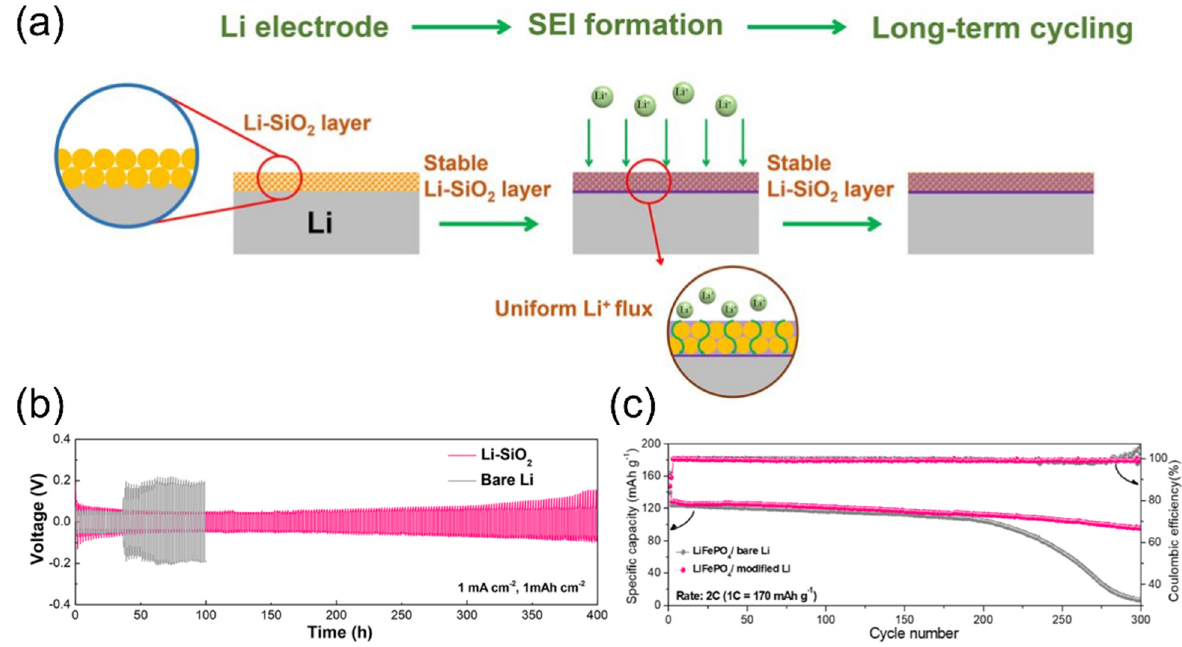
Figure 11. ( a ) Schematic drawing illustrating the fabrication of a conformal Li 4 SiO 4 -based hybrid layer for the dendrite-proof metallic lithium anode. ( b ) Electrochemical cycling stability of bare Li and modified Li symmetric cells (1 mA cm − 2 , 1 mA h cm − 2 ). ( c ) Long-term cycling performance of Li metal full cells. Reproduced with permission from ref. [66]. Copyright 2020, ACS Publications.